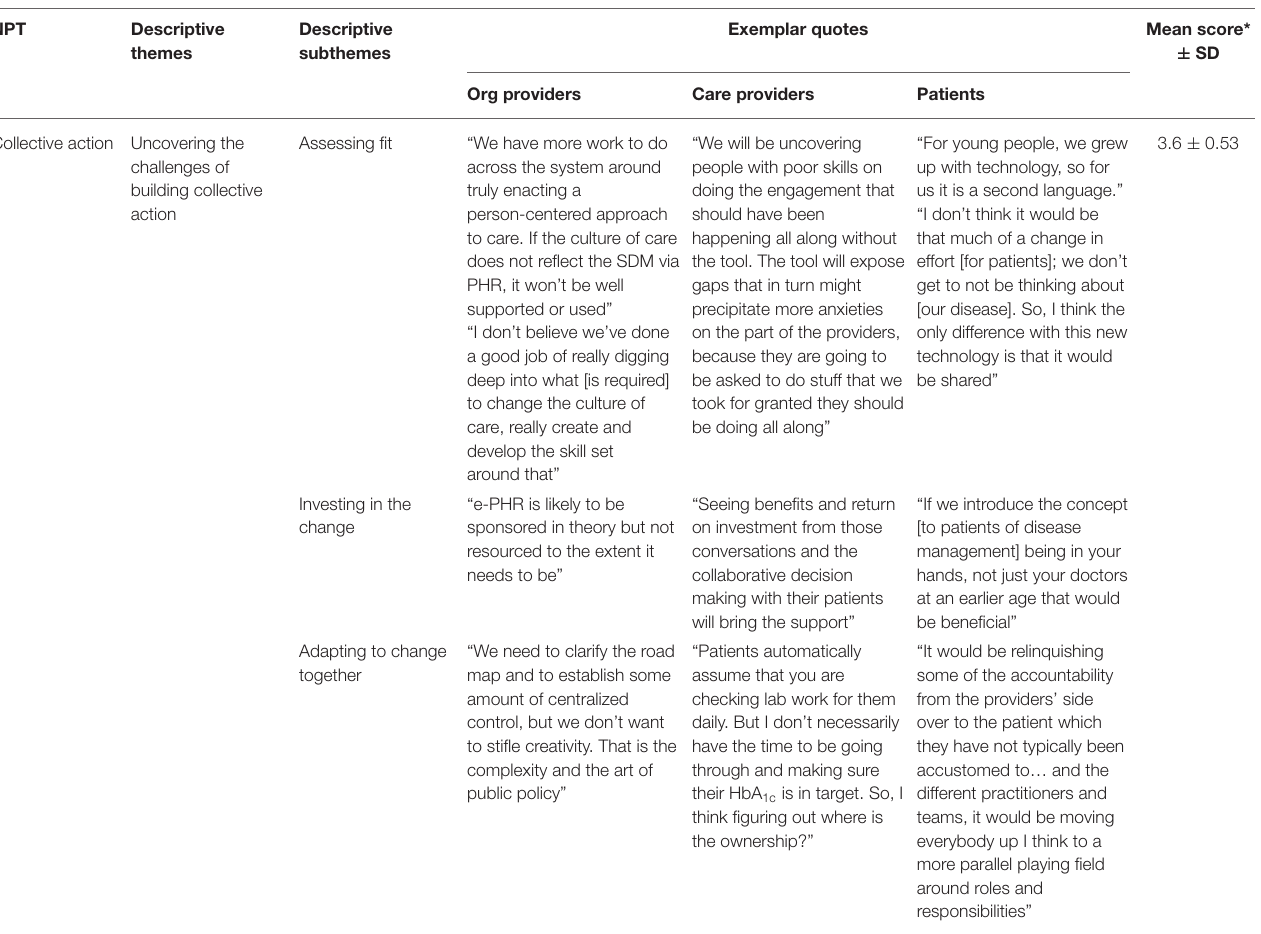
TABLE 7 | Combined qualitative and quantitative results for collective action by study group.